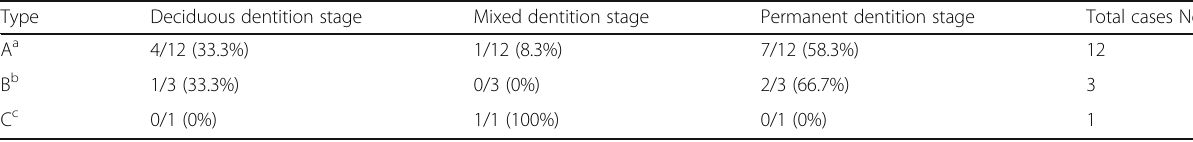
Table 2 Relationship of different POT types and dentition stage